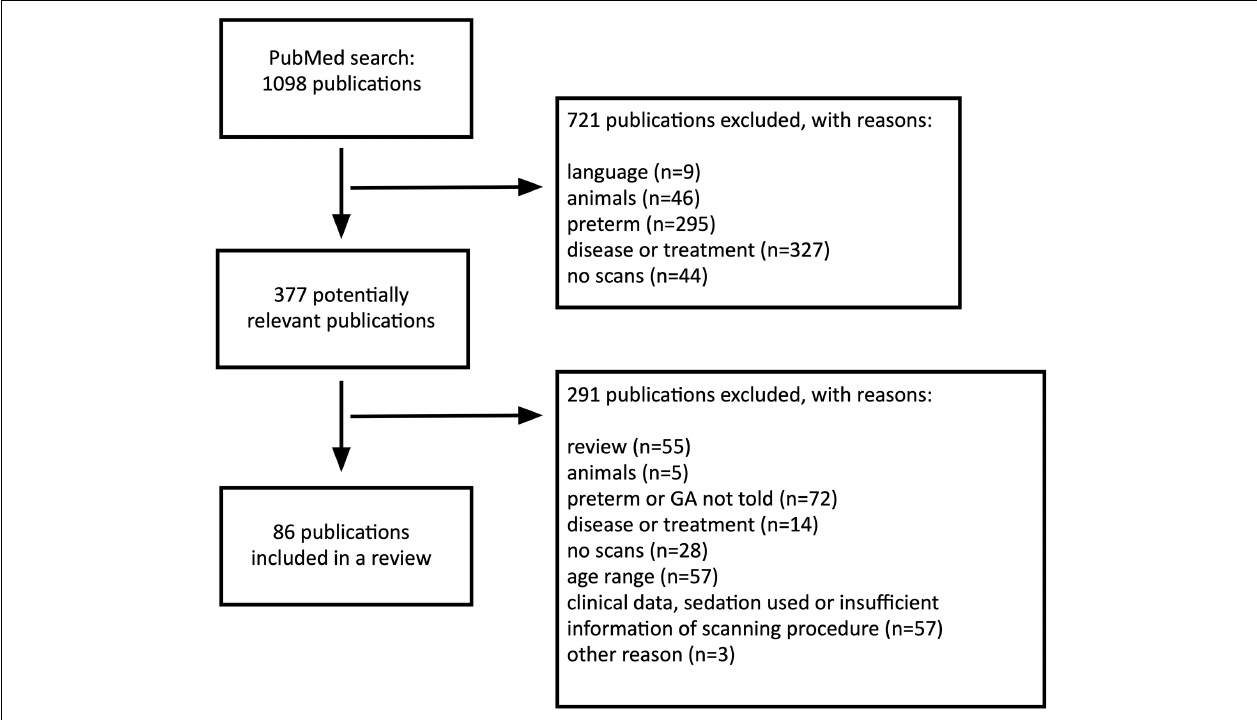
FIGURE 1 | Flow diagram outlining the literature